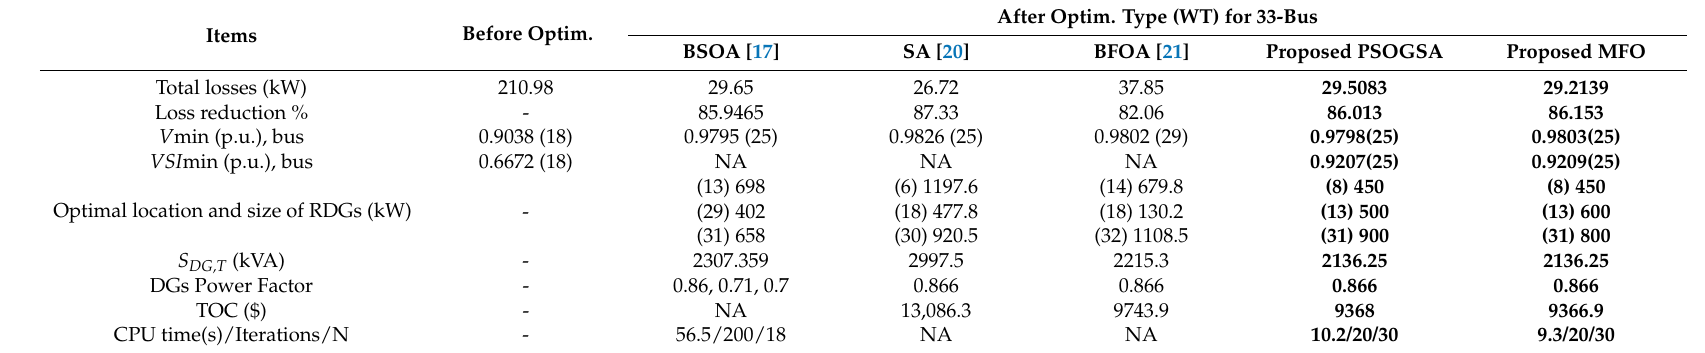
Table 4. The results of 33-bus IEEE distribution network at 0.866 PF (WT